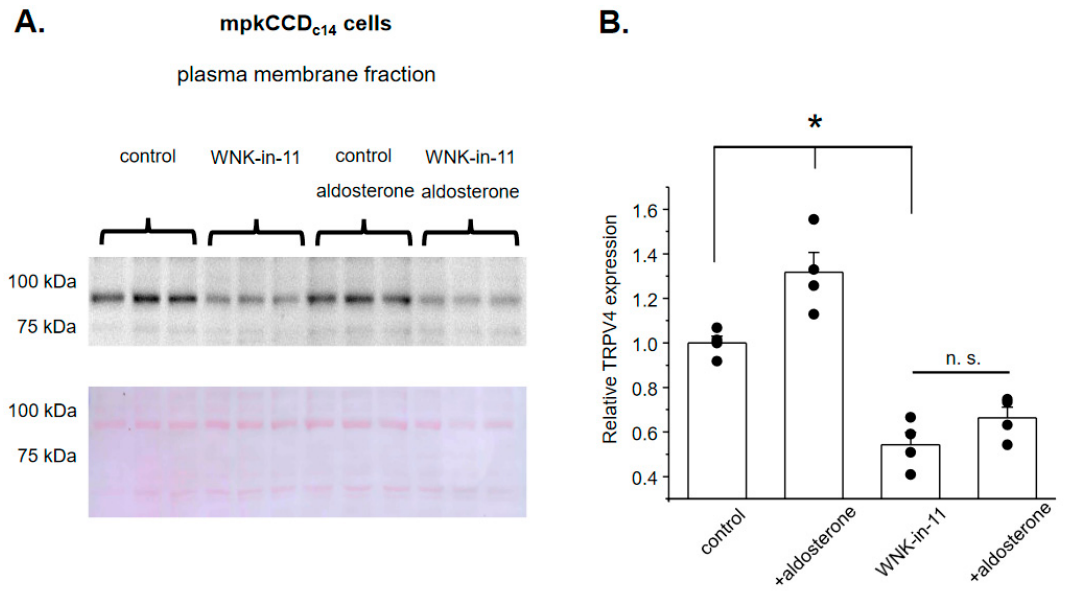
Figure 7. WNK1 governs translocation of TRPV4 to the plasma membrane in response to aldosterone. ( A ) Representative Western blot from the plasma membrane fraction probed with anti-TRPV4 antibodies in mpkCCD c14 cells kept on standard conditions (control), treated with aldosterone (1 µ M for 24 h), WNK1 inhibitor WNK-in-11 (400 nM for 24 h), and aldosterone together with WNK-in-11, as is indicated on top. The membrane fraction was separated using the giant plasma membrane vesicles’ isolation technique, as described in the methods. The Ponceau red staining of the same nitrocellulose membrane demonstrating equal protein loading is shown on the bottom panel. ( B ) Summary graph comparing plasma membrane TRPV4 expression levels in the conditions from panel (A). The intensity values were normalized to the total signal of the respective lines in Ponceau red staining. *—significant differences ( p < 0.05) or n.s—non-significant difference ( p > 0.05) between groups are indicated with respective lines on